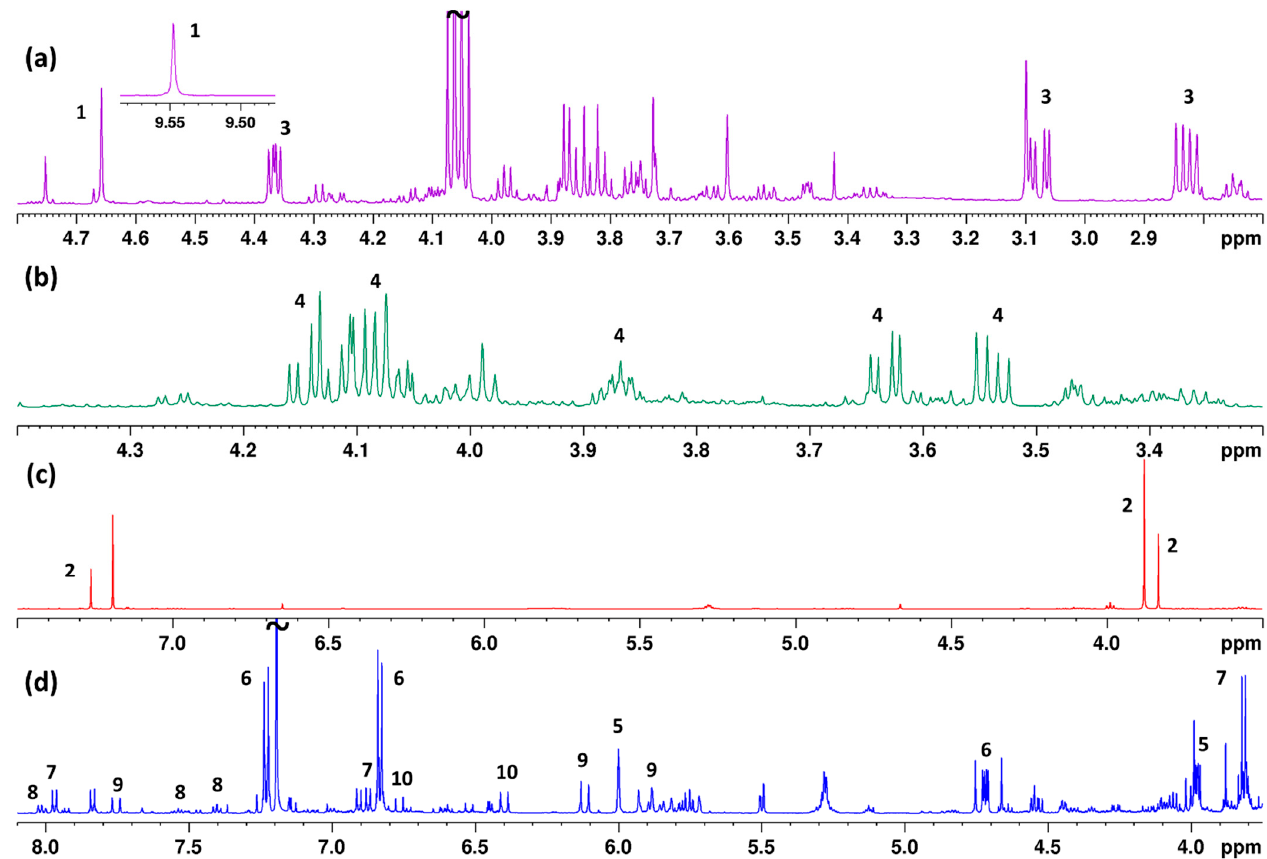
Figure 1. Representative 1D 1 H NMR spectra from samples of different botanical origins: ( a ) thyme, ( b ) plant, ( c ) blossom and ( d ) heather honey. Assigned metabolites: 5-hydroxymethylfurfural (5-HMF), 1 ; methyl syringate (MSYR), 2 ; 3-hydroxy-4-phenyl-2-butanone, 3 ; monosubstituted glycerol derivative (MG), 4 ; unedone, 5 ; 1-(4-methoxyphenyl)-ethane-1,2-diol, 6 ; 4-methoxybenzoic acid (4-MBA), 7 ; benzoic acid (BZA), 8 ; abscisic acid (ABA), 9 ; dehydrovomifoliol, 10 .